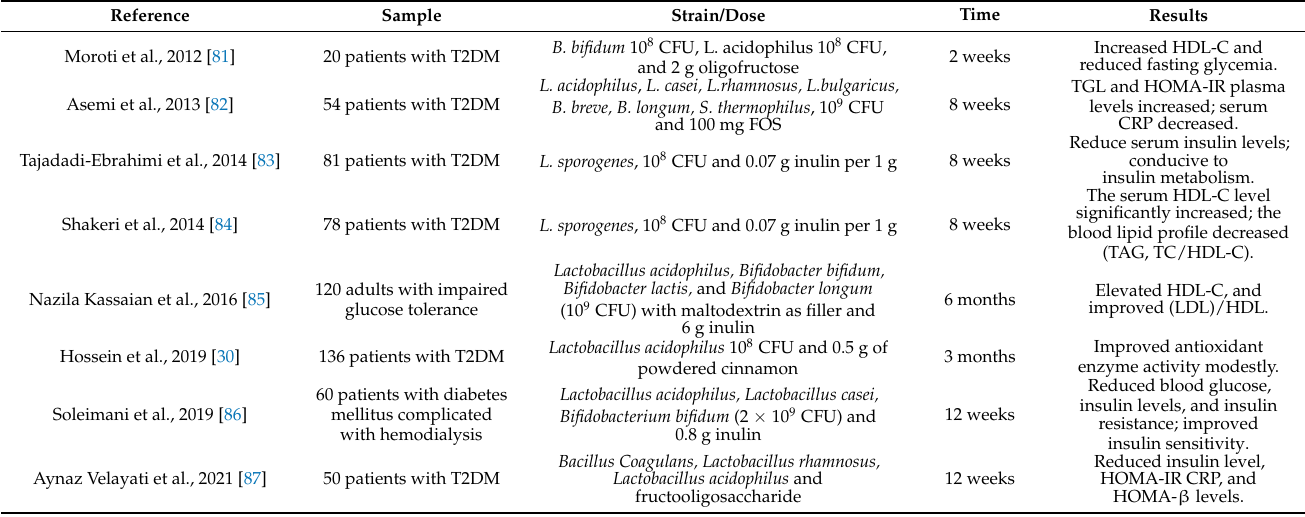
Table 2. Clinical studies of different synbiotics in the treatment of T2DM in recent